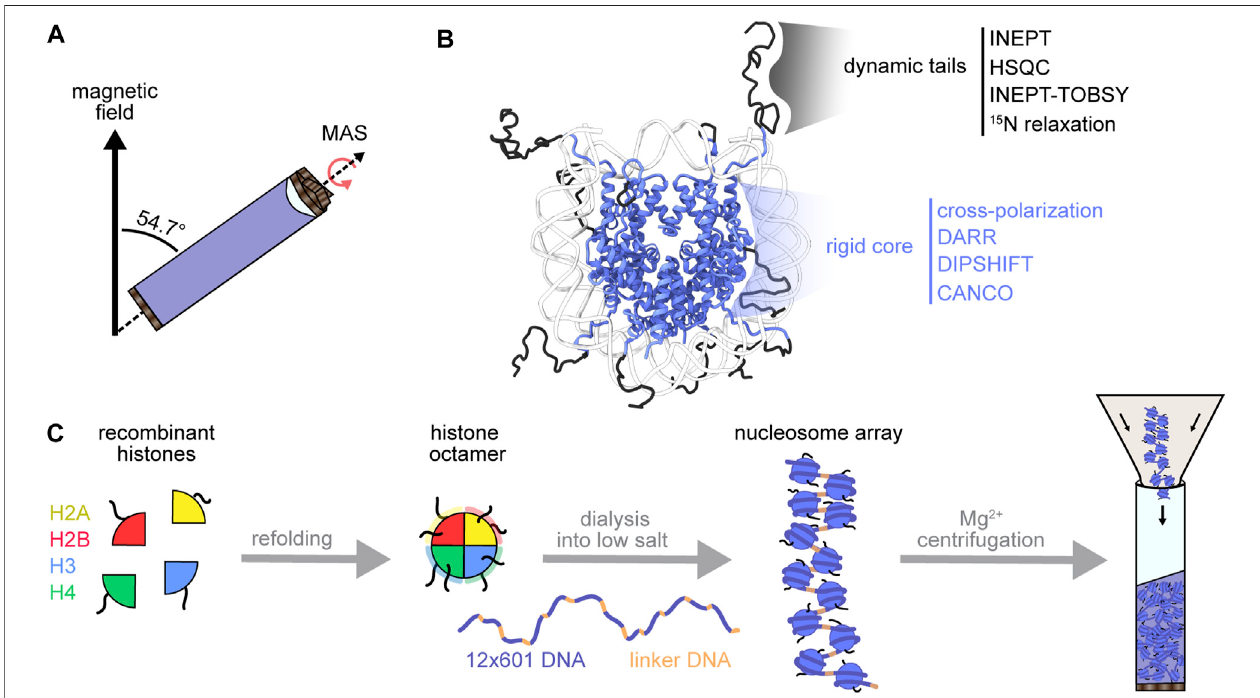
FIGURE 2 | MAS NMR toolbox for chromatin structural biology. (A) During MAS NMR, the sample rotor is spun at frequencies between 10 and 100 kHz at the magicangle(54.7 ° relative tothe external magnetic fi eld). (B) MAS NMRcan probethe dynamic range ofthenucleosomewithexperiments designed todetecteitherthe mobile histone tails or the rigid nucleosome core (PDB:1KX5) (Davey et al., 2002). (C) Chromatin reconstitution begins with the formation of histone octamers from recombinant histones, followed by DNA wrapping at low salt. Mg 2+ can be used to purify arrays and to compact chromatin during rotor